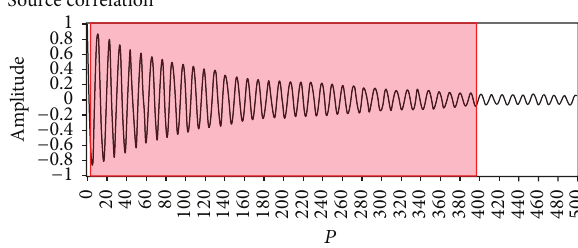
Figure 4: Illustration of the rule of thumbs for setting of 𝑝 .